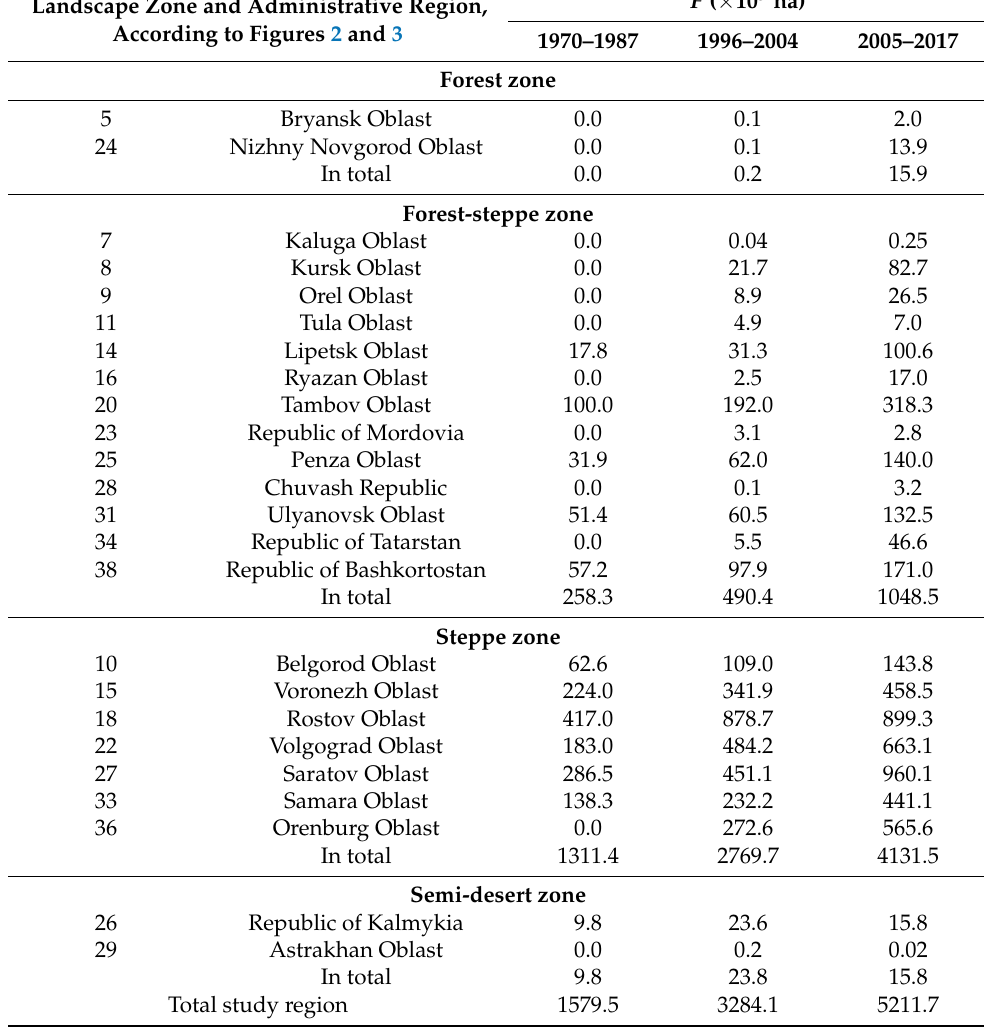
Table A1. Changes in the area ( F ) under sunflower in the landscape zones of European Russia during 1970–2017 (based on data from [51] and https://fedstat.ru (accessed on 15 September 2020)). Landscape Zone and Administrative